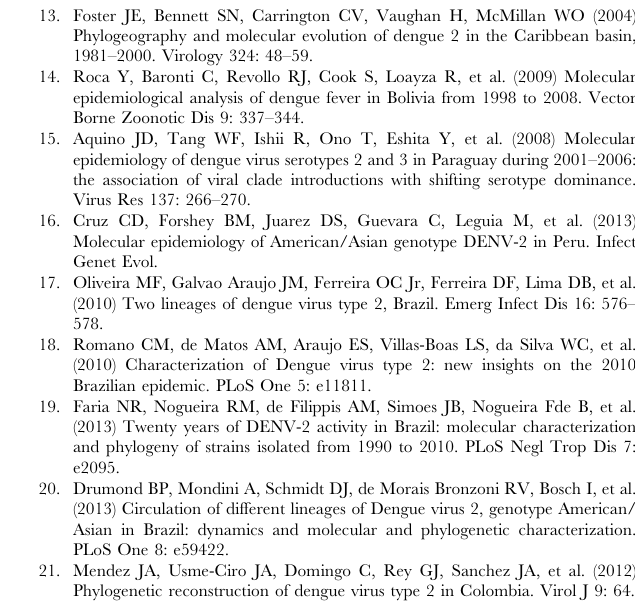
Table S2 Posterior state probability distributions